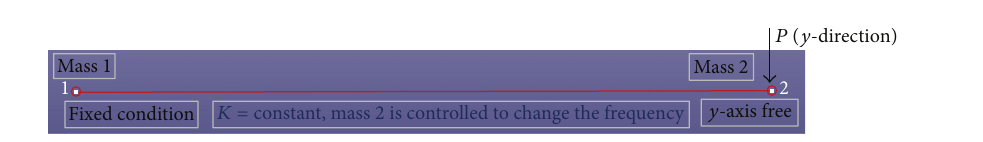
Figure 8: Composition of single degree of freedom